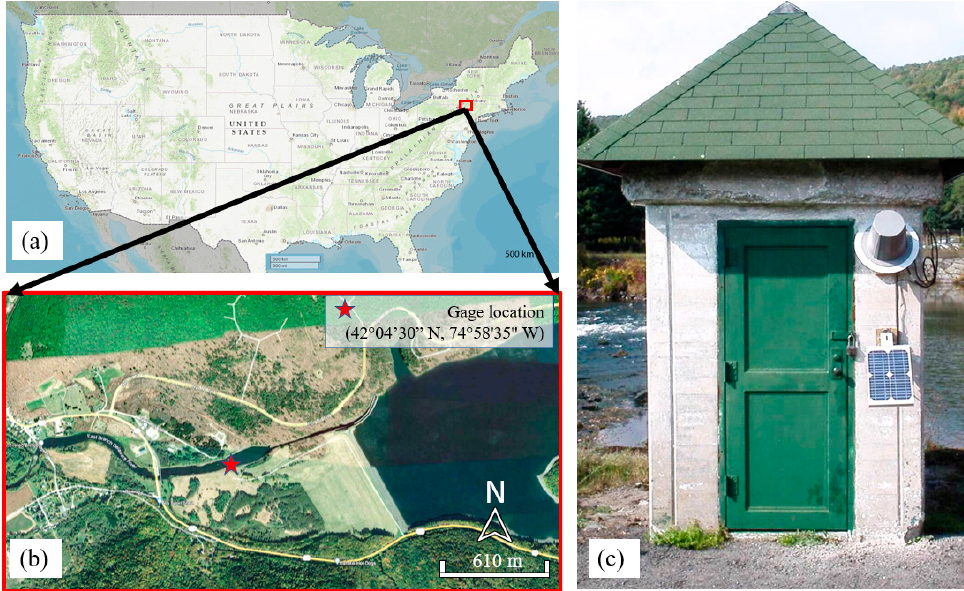
Figure 1. Aerial photo of the study location ( a , b ) with flow measuring station ( c ) at East Bank Delaware river (USGS 2022).